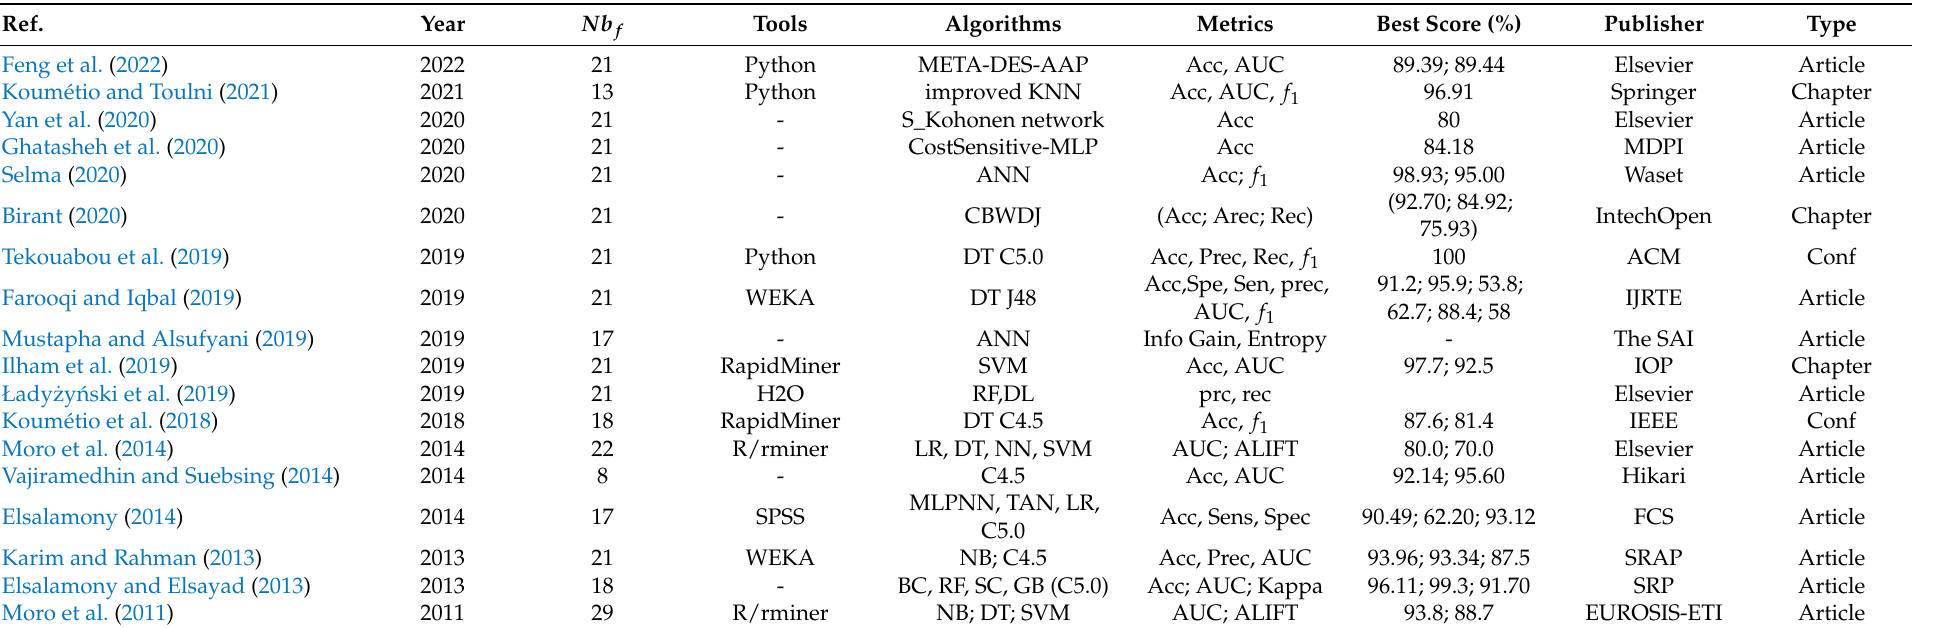
Table 1. Summary of the relevant papers dealing with direct bank telemarketing prediction using machine learning. SRAP = Scientific Research an